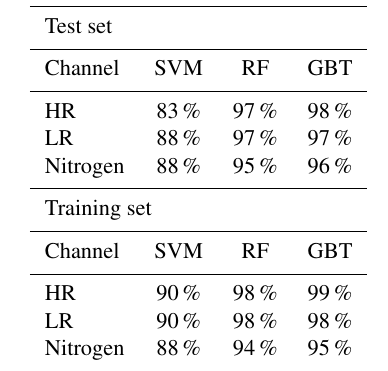
Table 2. Precision and recall values for the nitrogen, LR, and HR channels. The precision and recall values are calculated using the GBT